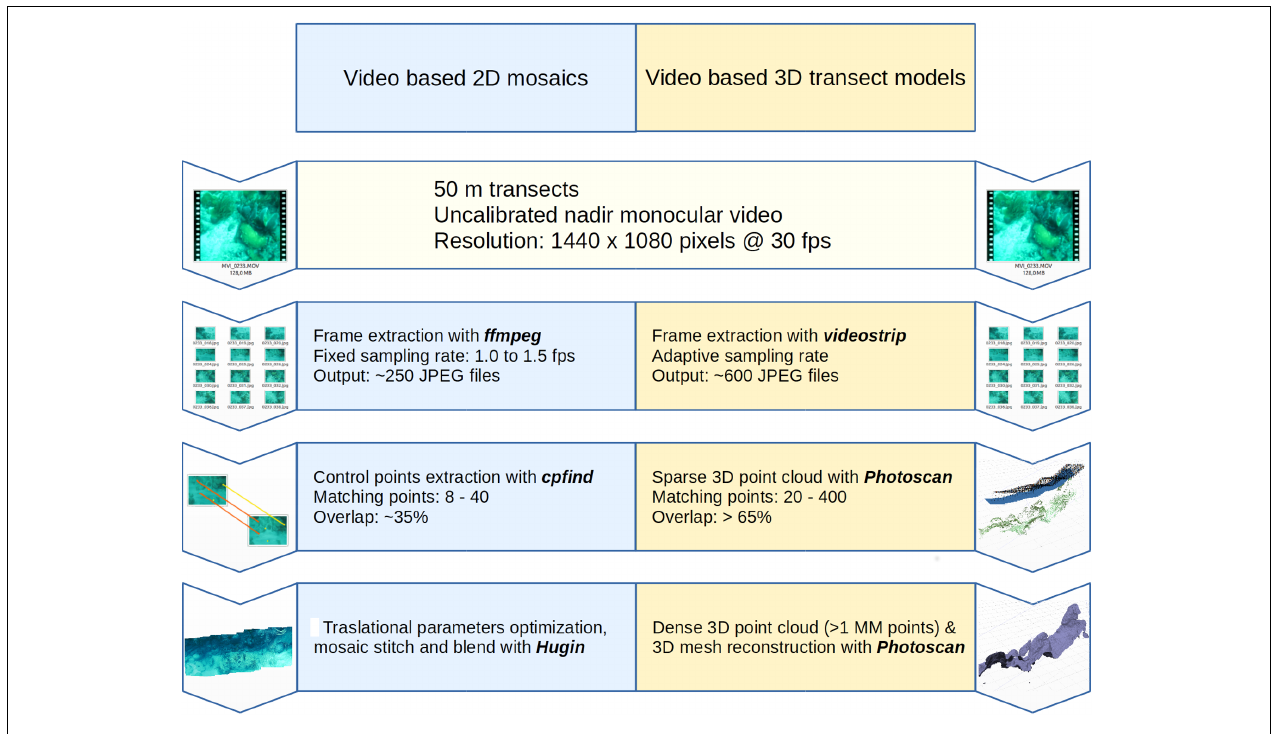
FIGURE 1 | Process to construct benthic mosaics and three-dimensional models.